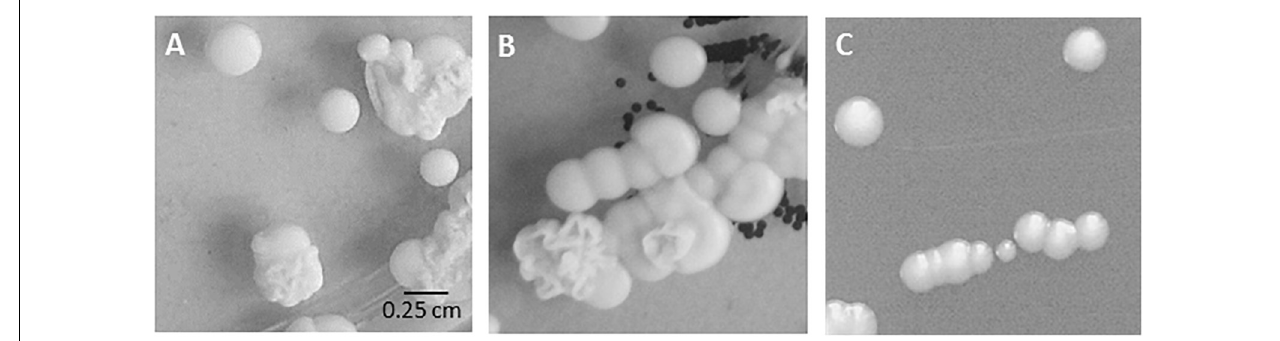
FIGURE 1 | Colony morphology in routine cultures. Mixed fungal growth on original Sabouraud’s agar plates from (A) nose swab (specimen 1701), (B) throat swab (specimen 1702). (C) Isolate bsc-1700 (blood culture, smooth colony, specimen 1700) on Sabouraud’s agar